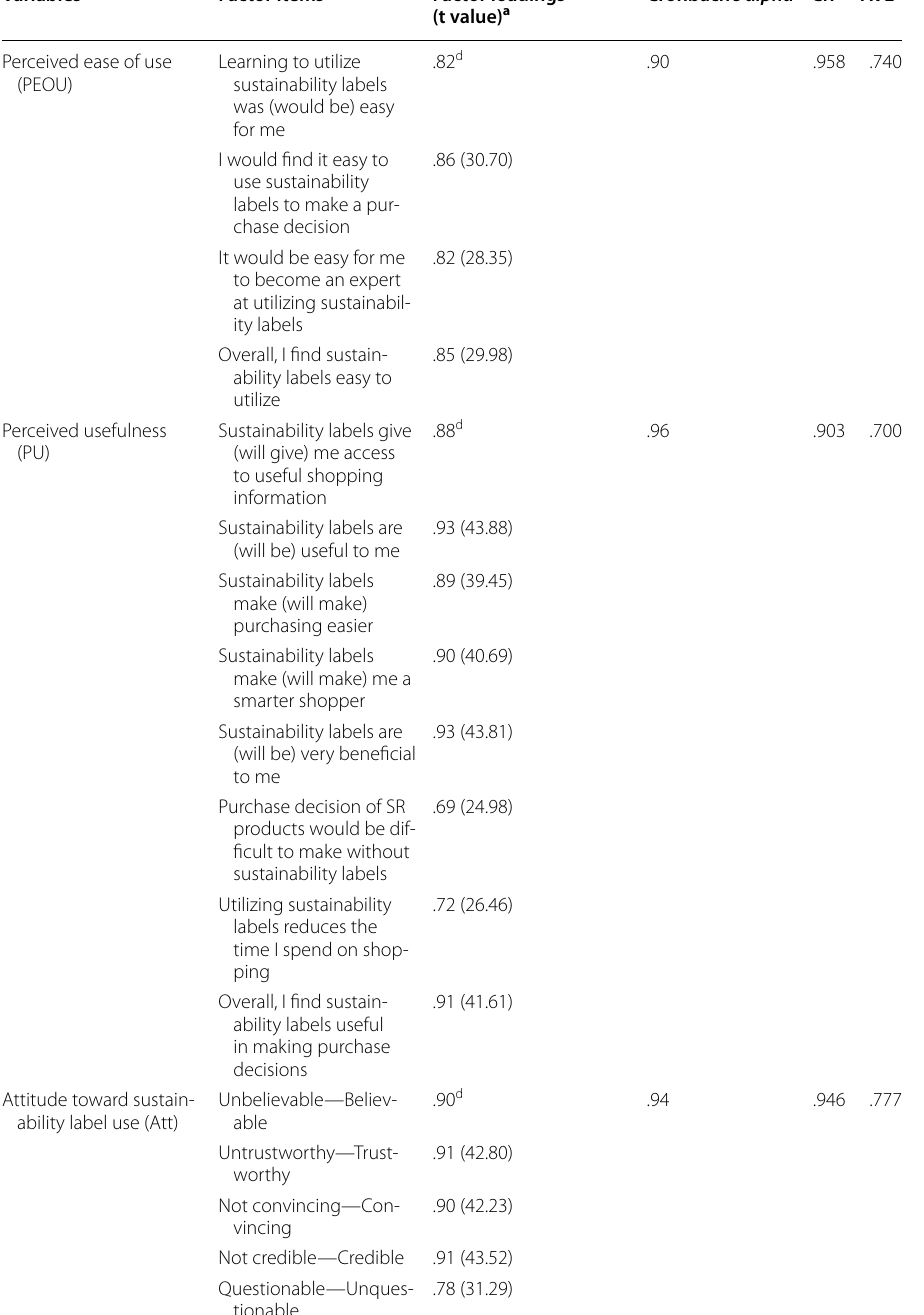
Cronbach’s alpha CR b AVE c (t value) a